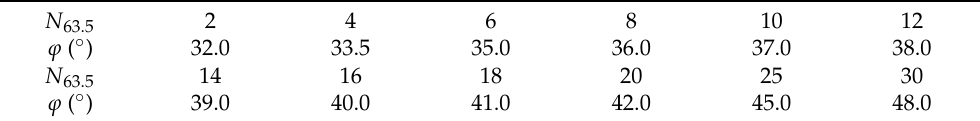
Table 3. Empirical relationship between N 63.5 and ϕ for rubble.